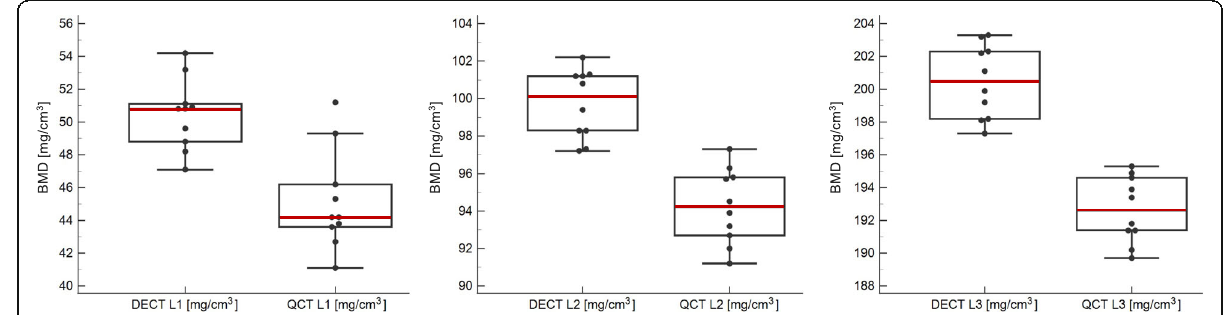
Fig. 3 Box and whisker plots show DECT-based mean BMD values for L1 (50 mg/cm 3 ), L2 (100 mg/cm 3 ), and L3 (200 mg/cm 3 ) of 50.47 ± 2.17 mg/cm 3 , 99.72 ± 1.84 mg/cm 3 , and 200.48 ± 2.24 mg/cm 3 , respectively; QCT-derived mean BMD values were 45.16 ± 3.04 mg/cm 3 , 94.26 ± 2.00 mg/cm 3 , and 192.66 ± 2.02 mg/cm 3 , respectively. The red line illustrates the mean and the black box edges represent the 25th and 75th percentiles. Statistical comparison resulted in significant differences between DECT and QCT for L1, L2, and L3 (all p < 0.001). DECT, Dual-energy computed tomography; BMD, Bone mineral density; L, Lumbar vertebra equivalent; QCT, Quantitative computed